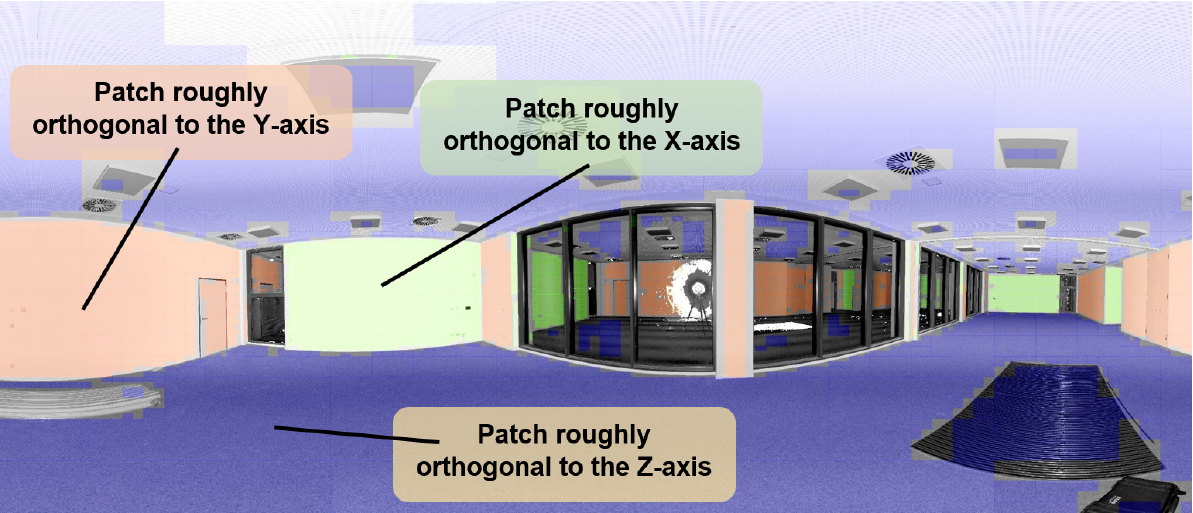
Figure 5. The detected patches are colored according to your skin direction. In our case, this also makes it easier to assign the TLS patches to the BIM faces. Please note, that the labeled patches correspondent to the faces in figures Figure 3 These parameters change the size of the found patches. Please